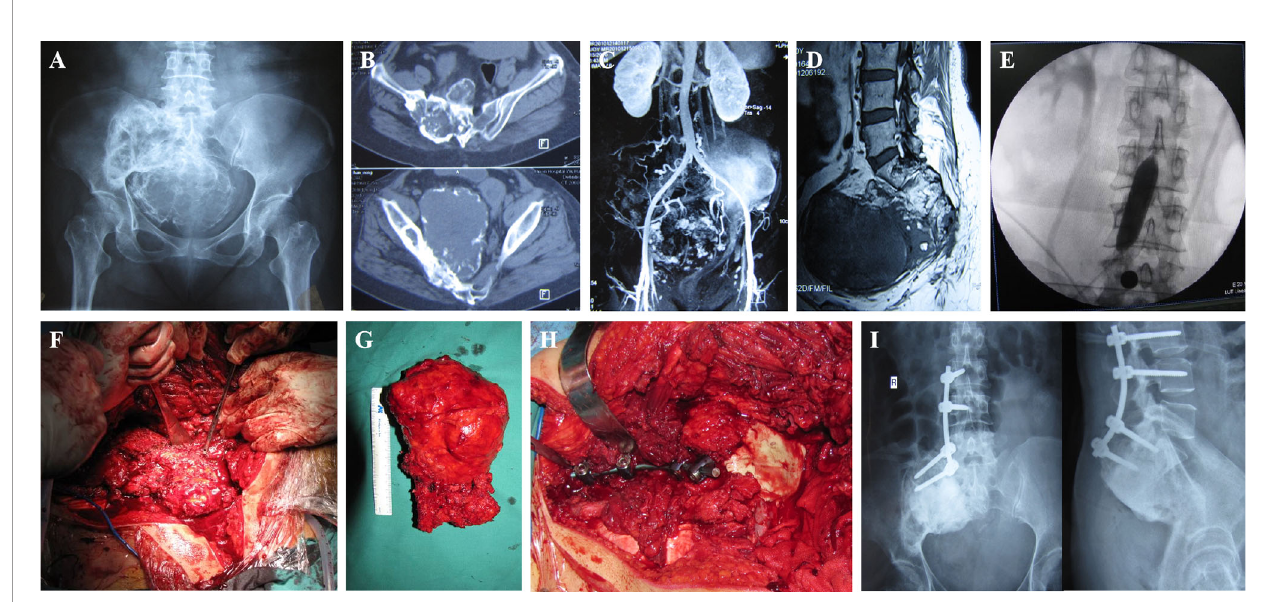
FIGURE 3 | A 50-year-old female patient witha giant celltumor of bone. (A) Preoperative X-ray shows a right sacroiliac joint tumor. (B) Preoperative computed tomography (CT) shows a right sacroiliac joint tumor. (C) Angiography showing abundant bloodsupply in the tumor. (D) Magnetic resonance imaging (MRI) showing mixed signalsinthe tumor. (E) Abdominal aorta balloon blockisusedto controlsurgical bleeding. (F) Enbloc resectionof the tumor. (G) General view of the specimen. (H) Bone cement combined withlumbar iliac screw fi xation. (I) Twenty-seven months postoperative X-rayshows no loosening or fracture of screws andconnecting rods.